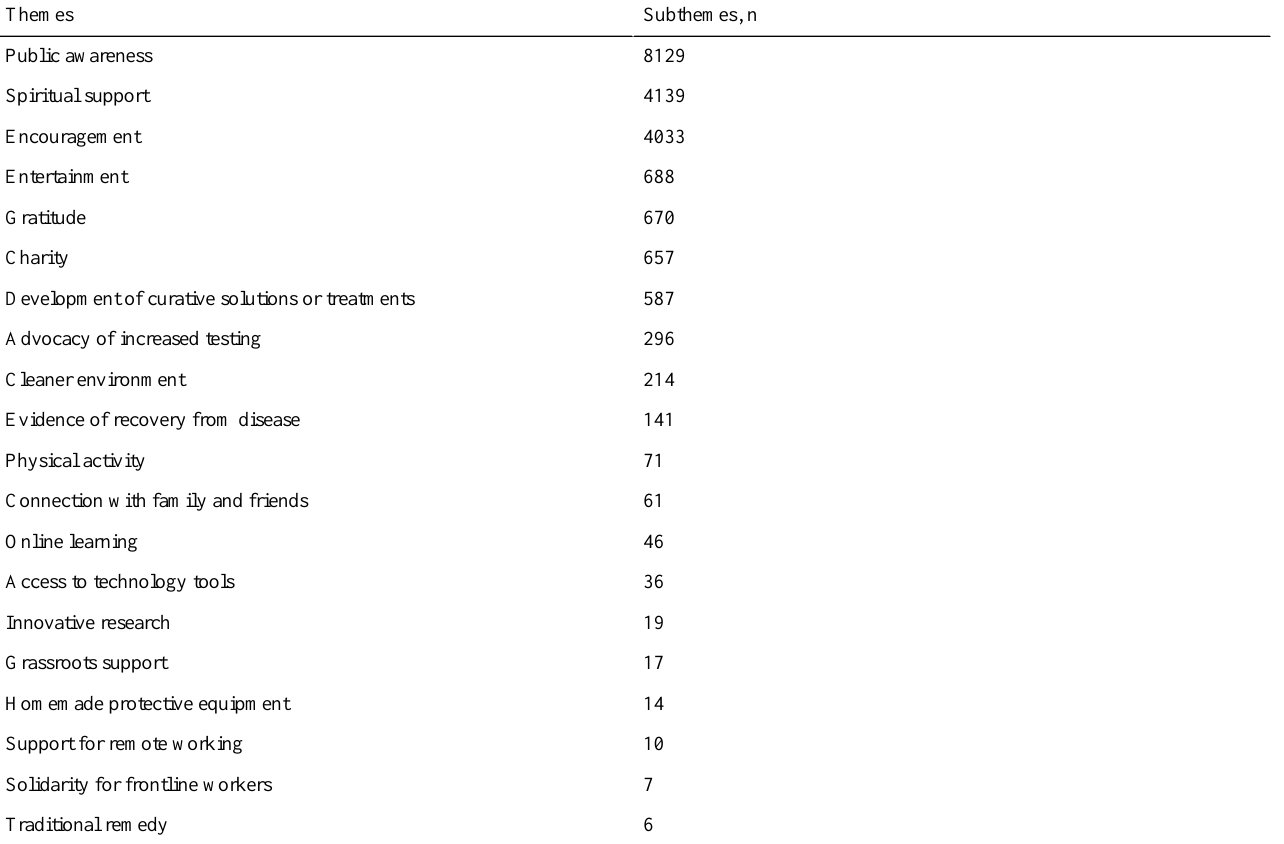
Table 8. Positive themes and the corresponding number of